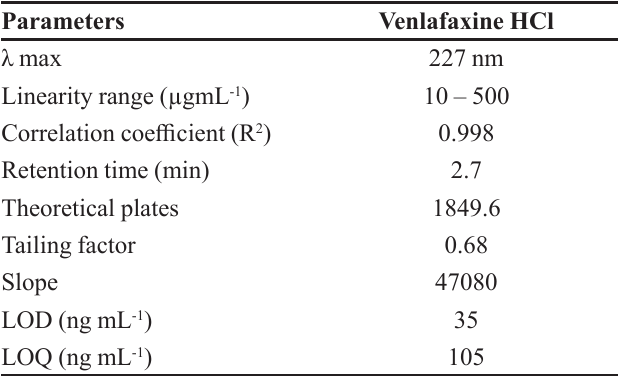
TABLE IV - System suitability parameters for venlafaxine HCl Parameters